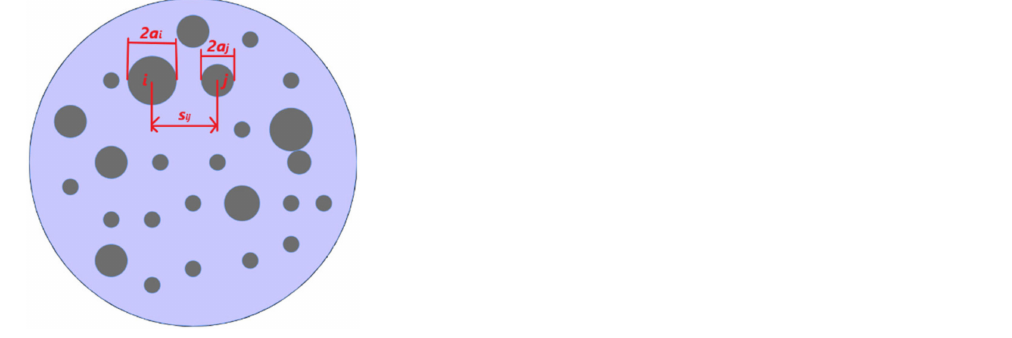
Figure 4. Greenwood’s contact resistance model showing multiple spots ( a i —radius of the i th spot; a j —radius of the j th spot; s ij the distance between the i th and j th spot).